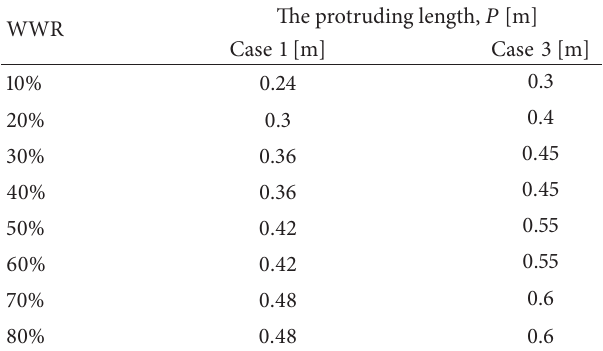
Table4:Protrudinglengthsdifferenceofhorizontalshadingdevices in the south